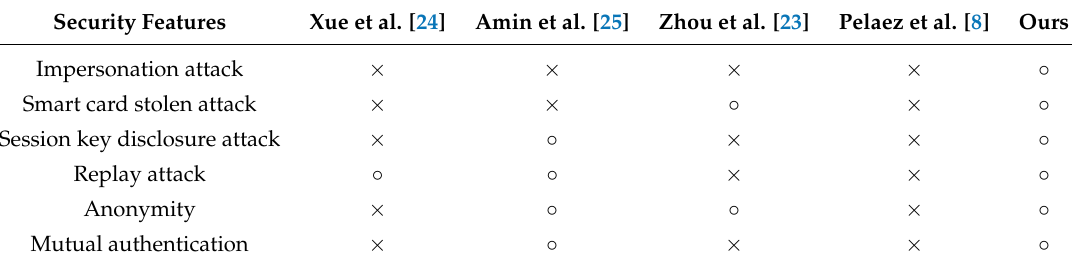
Table 1. Security features